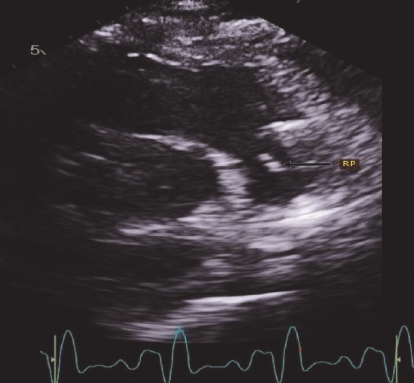
Figure 4: Echocardiographic view of the Impella RP in the right ventricular outflow